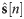
An example of a failed attempt to separate muscular artifacts from 111 channel EEG record.(A) EEG signals x[n] corrupted by EMG artifacts (for spatial reasons only 25 out of 111 EEG channels are shown). (B) The source components s^[n] provided by ICA (again for spatial reasons only 25 out of 111 components are shown; the remaining components look very similar to those that are presented—they are composed of occasional bumps, and no clear separation of EEG and muscular artifacts can be recognized).